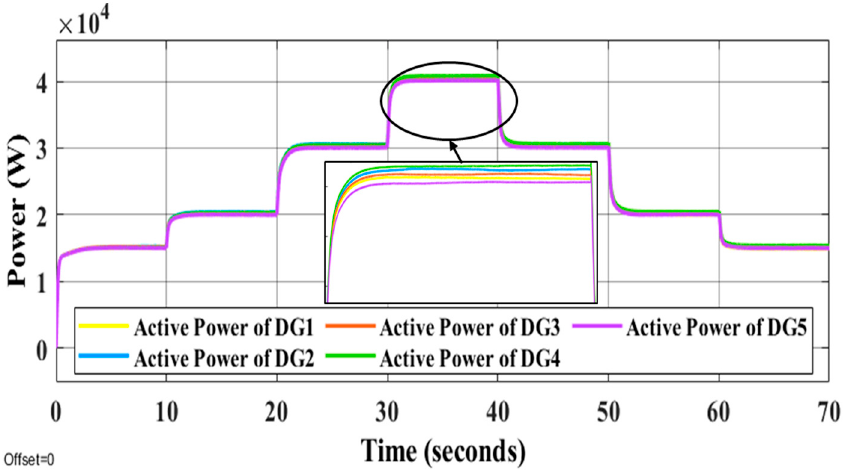
Figure 14. Active power of all DGs under the changing of load conditions.